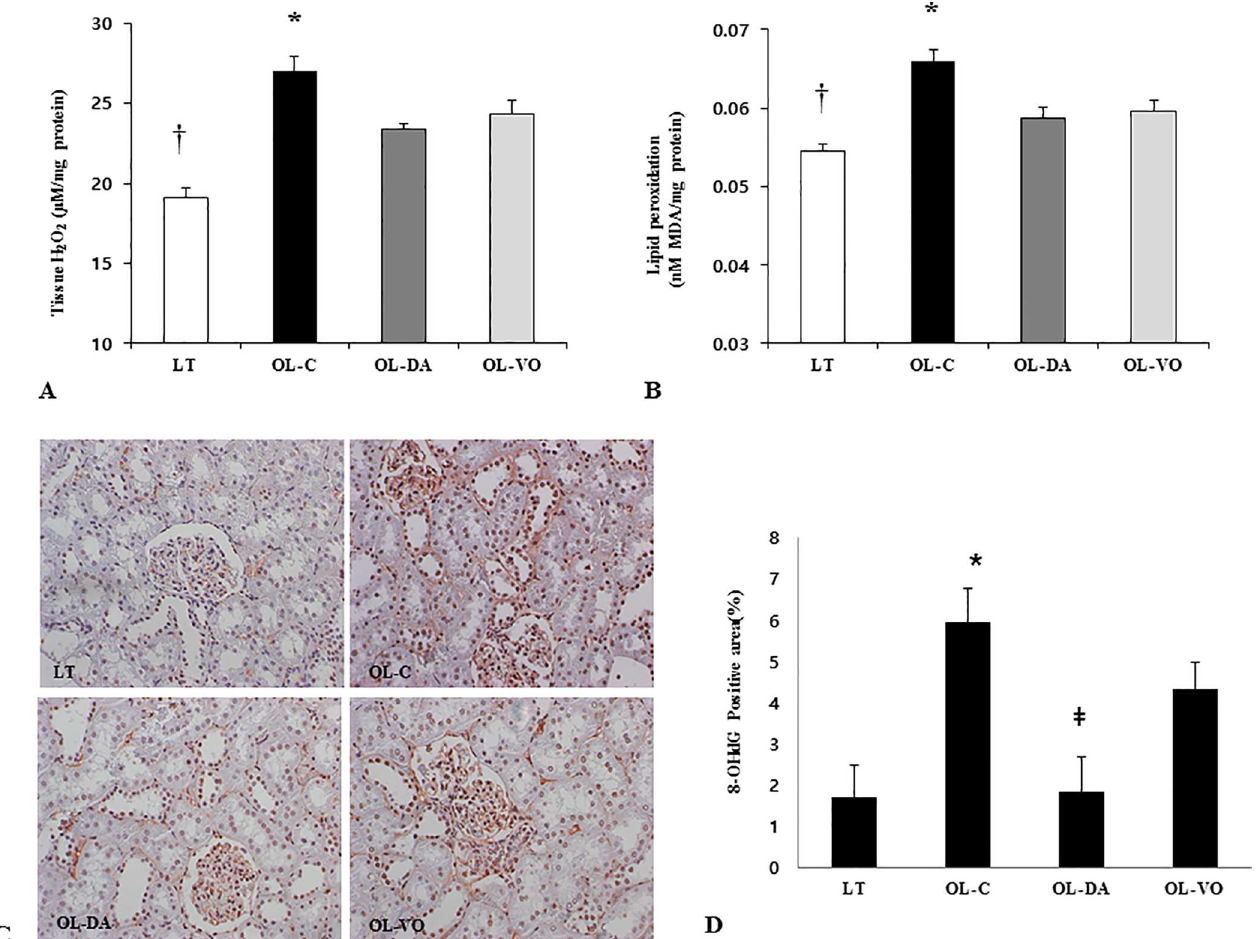
Fig 5. Oxidative stressmarkersin renal tissues. The levels of renal H 2 O 2 (A) and malondialdehyde(MDA) (B), 8-OHdG immunostaining (x 200, C), quantitativemeasurement of 8-OHdG staining (D) in LETO (LT) and OLETF rats with saline(OL-C), dapagliflozin (OL-DA) or voglibose (OL-VO) treatment. * P < 0.05, OL-C vs. other groups; † P < 0.05, LT vs. other groups; ‡ P < 0.05, OL-DA vs. OL-VO. Values are expressed as means ± SE. 8-OHdG, 8-hydroxy-2-deoxy